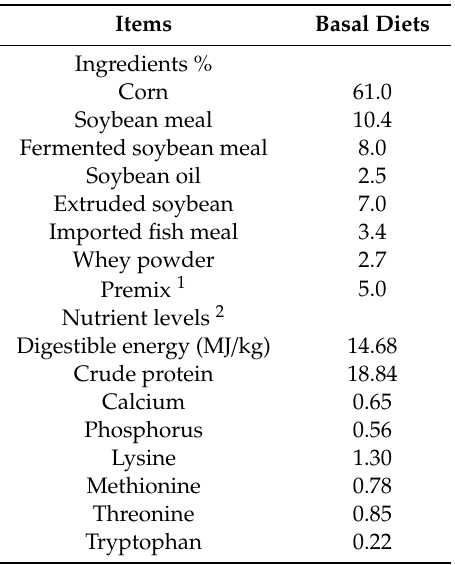
Table 1. Composition and nutrient contents of the basal